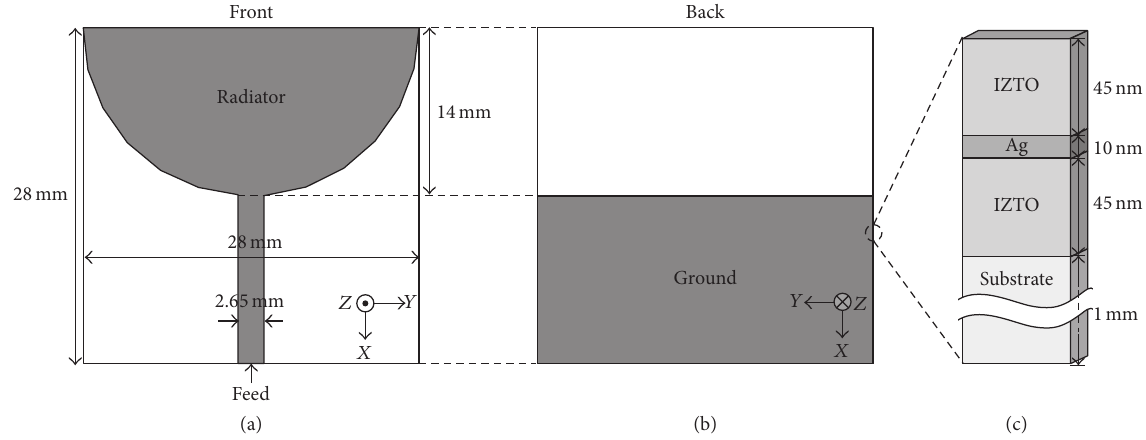
Figure 1: Design and dimension of the UWB antenna. (a) Front view. (b) Back view. (c) Structure of IZTO/Ag/IZTO multilayer electrode film and substrate.